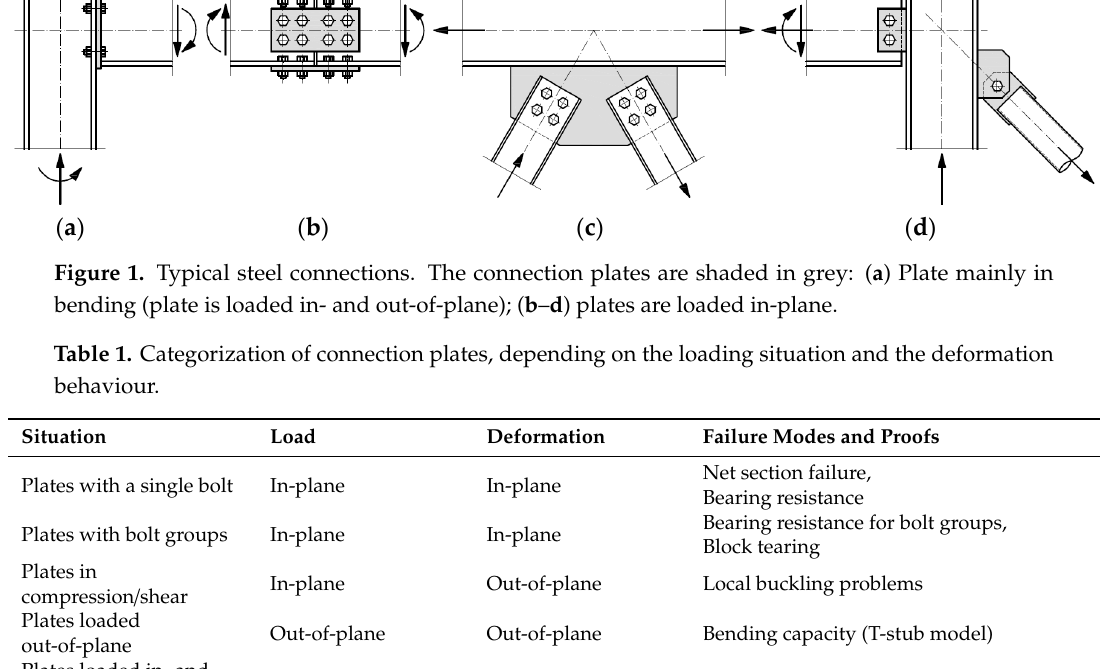
Table 1. Categorization of connection plates, depending on the loading situation and the deformation behaviour.